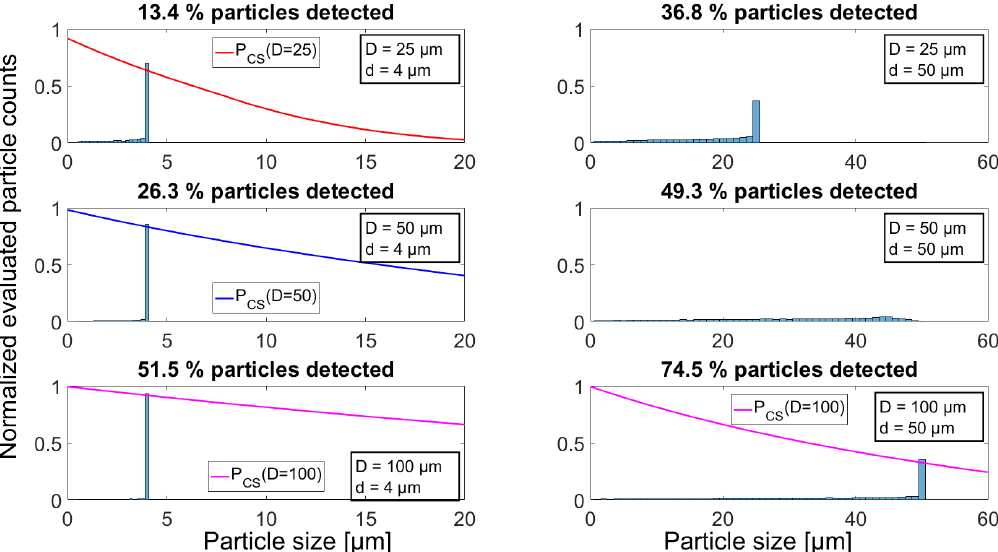
Figure 9. Normalized histogram presentation of the detected particles when using three different aperture sizes. The left column shows how the evaluated size of 4µm diameter particles are distributed using different aperture sizes, while the right column represents the size evaluation of 50µm diameter particles. The used bin width in all histograms are chosen for best visual presentation of the results. Theoretical probabilities for obtaining a complete sample as a function of particle diameter were introduced in Figure 2, and are recreated in the left column and bottom right (red, blue and magenta lines) for comparing simulated and theoretical